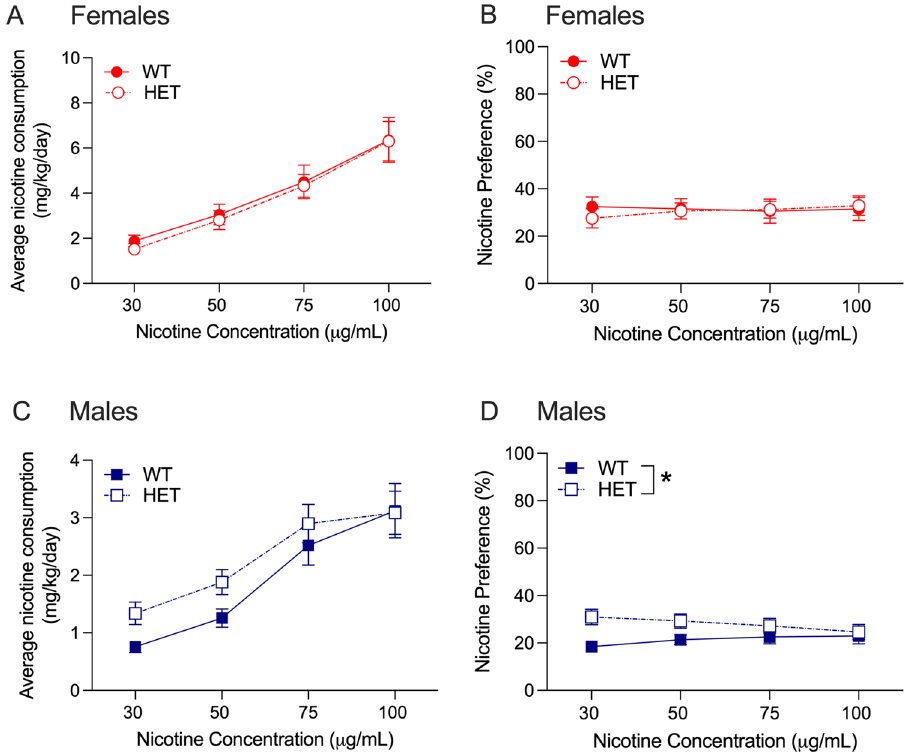
Figure 5. Nicotine consumption and preference in Slc39a8 WT and HET mice. No differences between female Slc39a8 WT and HET mice were observed for ( A ) nicotine consumption or ( B ) nicotine preference. ( C ) No genotype differences were observed in nicotine consumption between male Slc39a8 WT and HET mice. ( D ) Male Slc39a8 HET mice showed greater overall nicotine preference compared with WT littermates. * P = 0.049 for main effect of genotype. Data are presented as mean ± SEM, n = 21–22 female mice per genotype, n = 32–38 male mice per